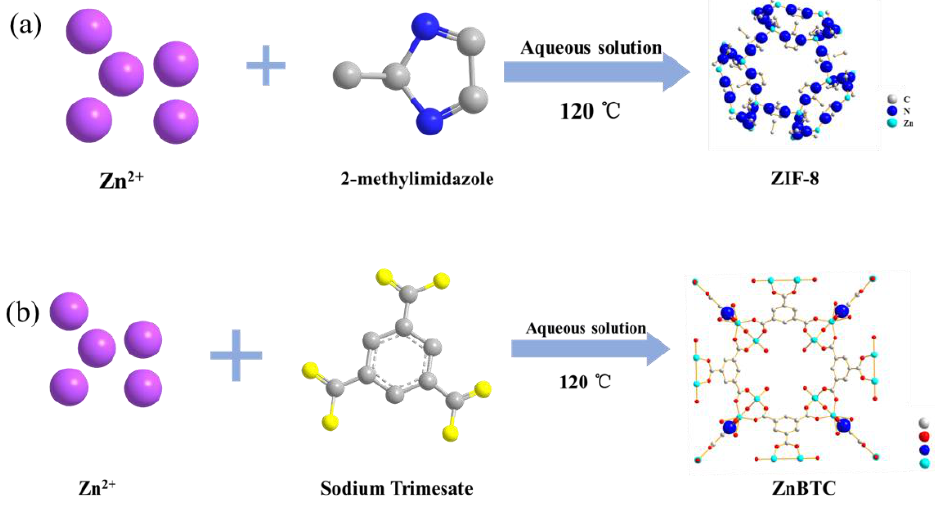
Figure 1. Diagrammatic flow charts of ZIF-8 ( a ) and ZnBTC ( b ). In the reaction systems, infinite Zn chains are interconnected by the organic ligand linkers into a three-dimensional microporous framework. Due to their porous structures with different functionalized channels, the ZnBTC and ZIF-8 show promise for use as adsorption